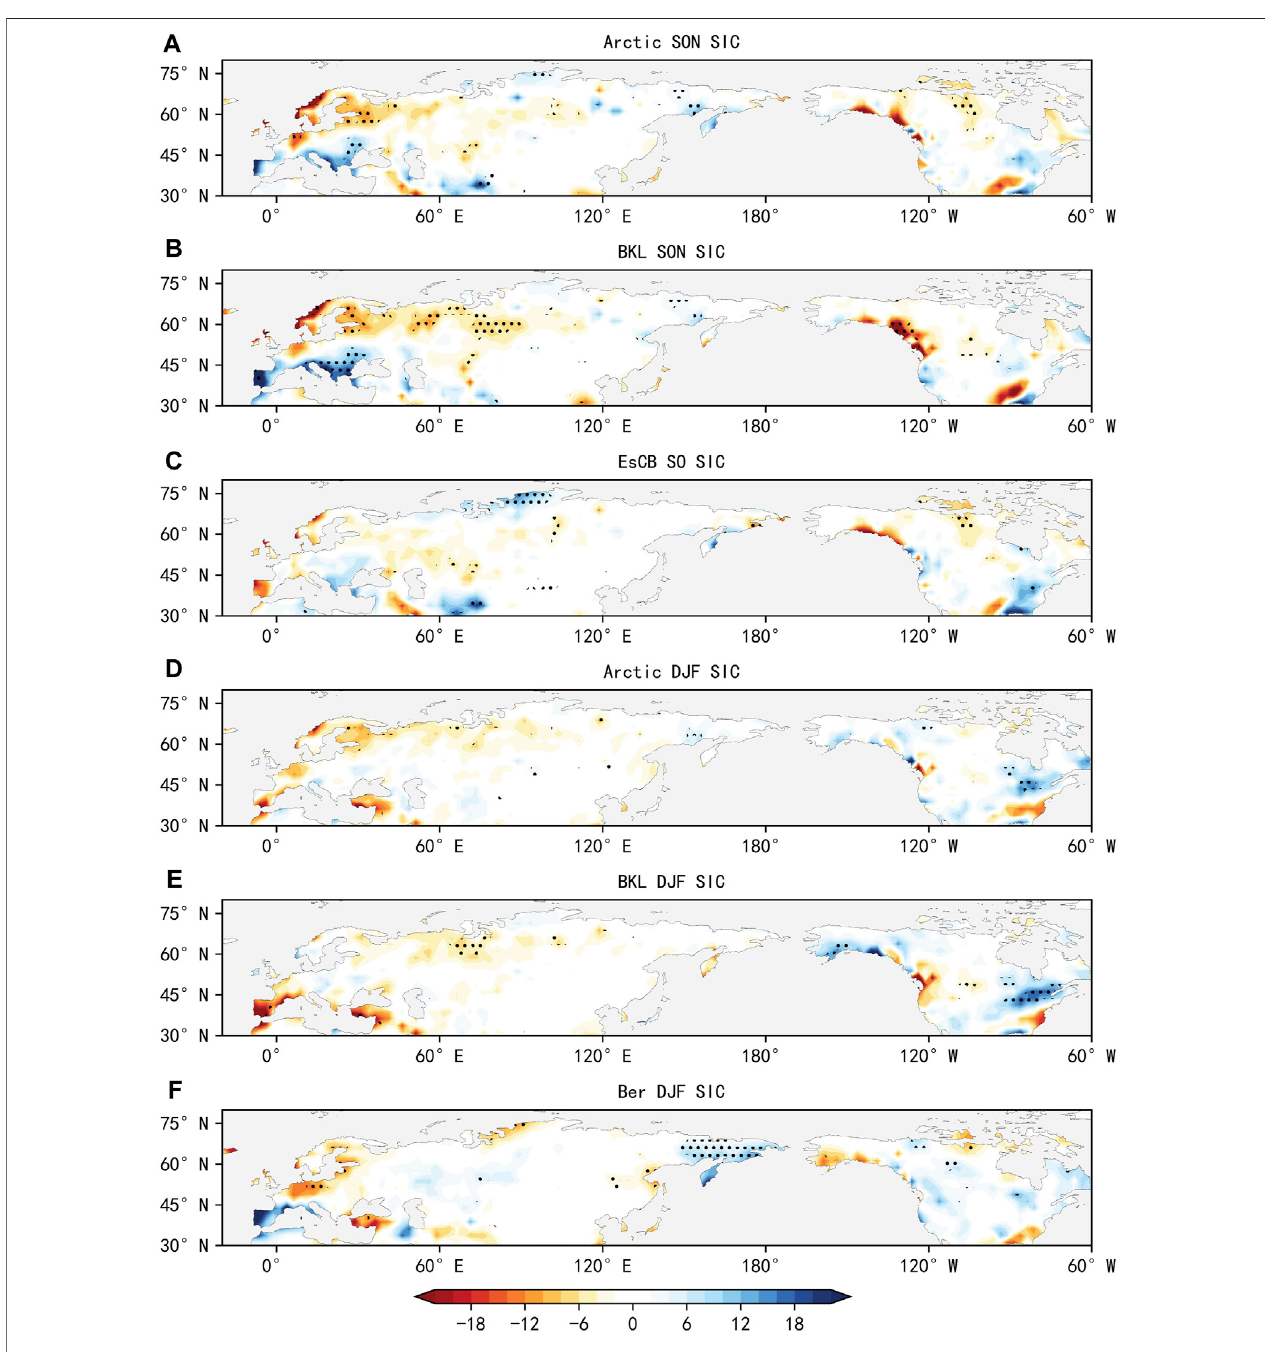
FIGURE 6 | As Figures 3A – C and Figures 3G – I but for monthly mean precipitation over land (unit: mm).